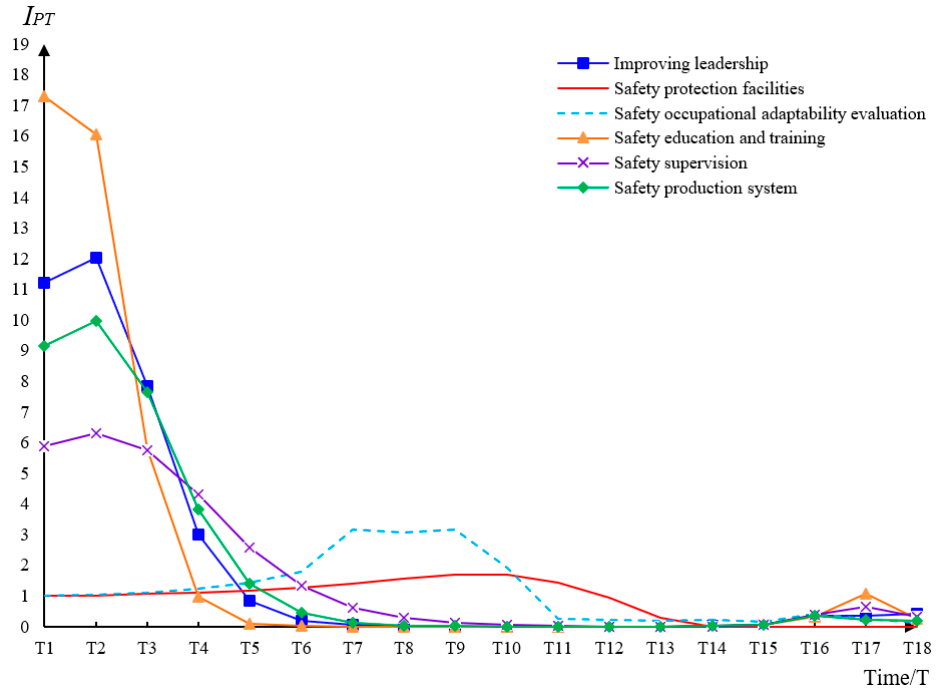
Figure 7. The analysis of I PT change with T based on organizational management.